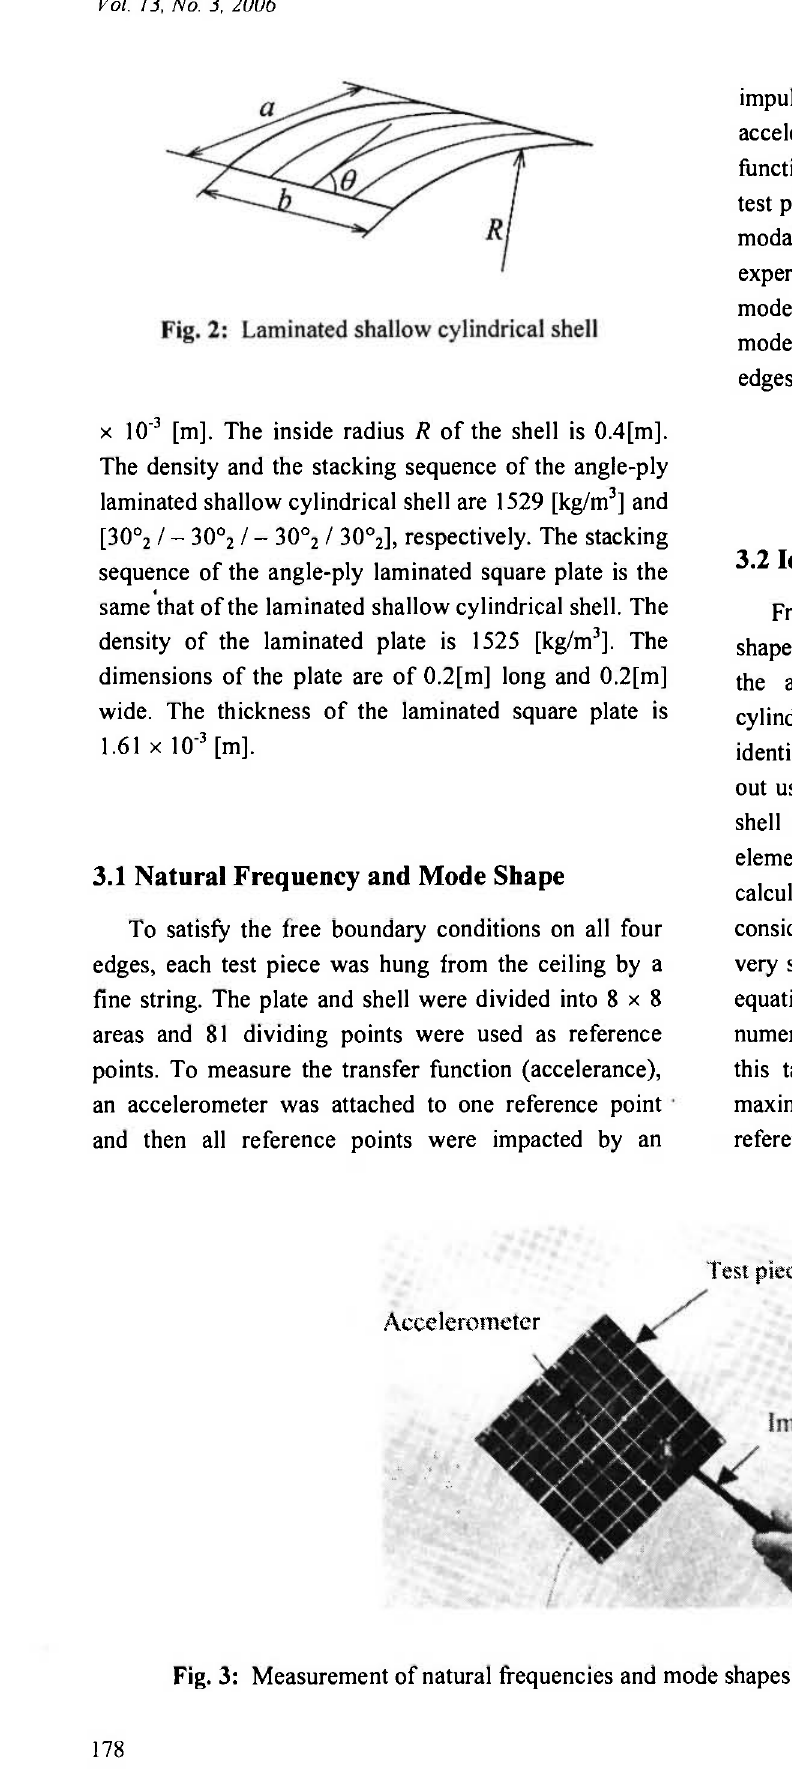
Fig. 3: Measurement of natural frequencies and mode shapes by experimental modal analysis